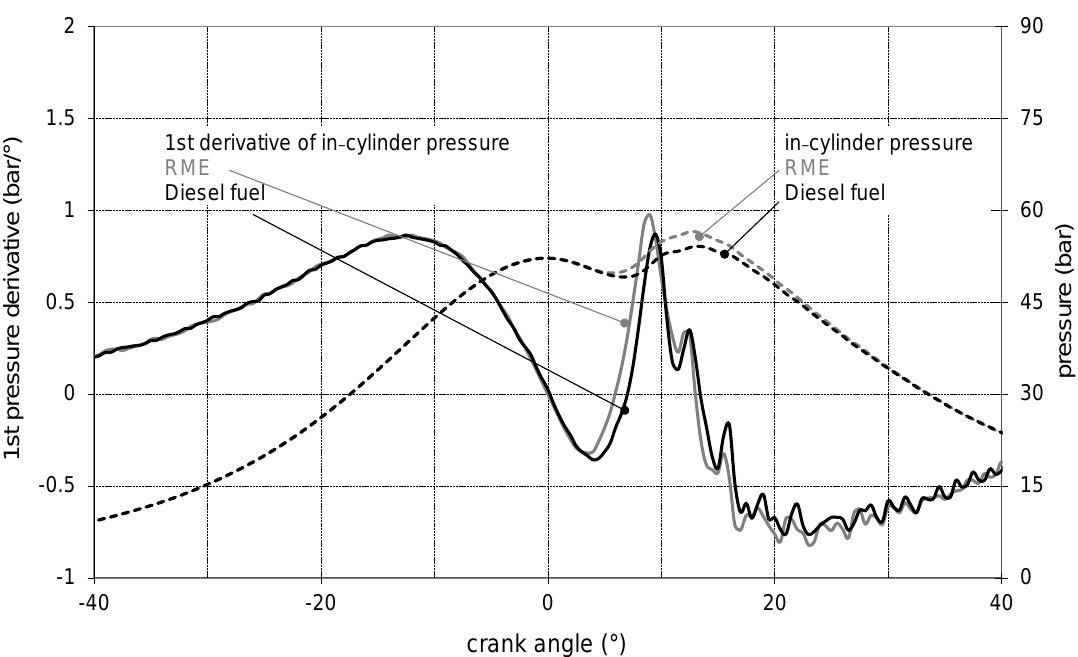
Figure 19. RME and diesel fuel in-cylinder pressures and rate of pressure rise at 3000 rpm and at full load.